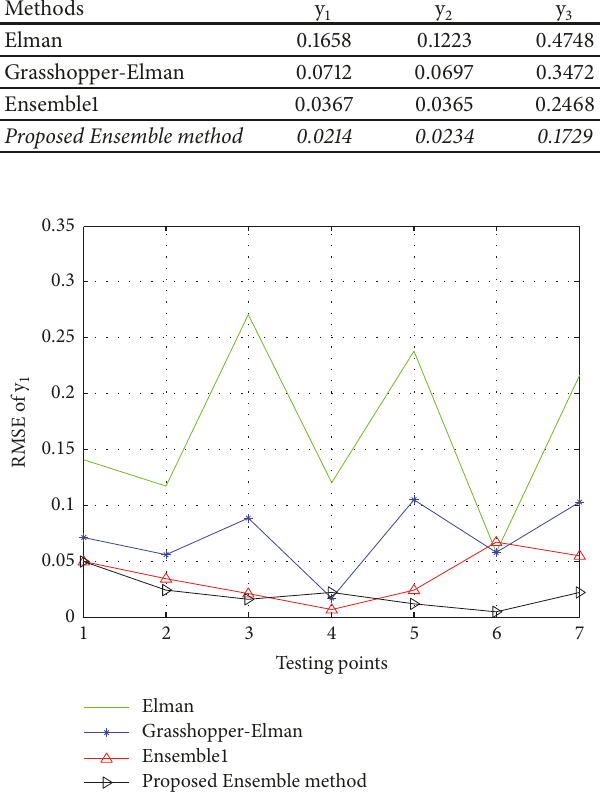
Figure 5: Prediction RMSE of y 1 .